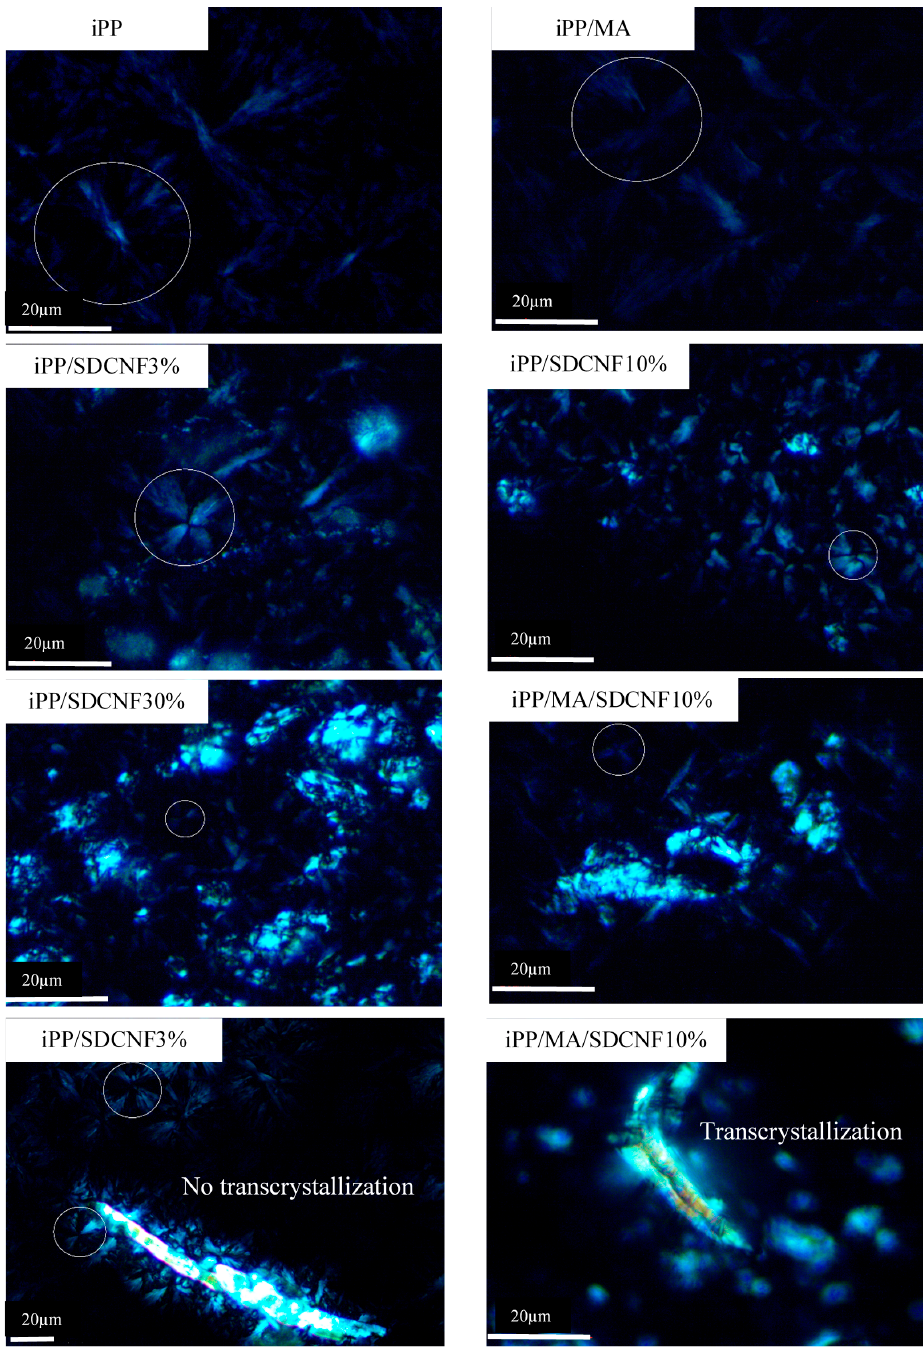
Figure 7. Polarized light micrographs of iPP and iPP/SDCNF composites. Bright and irregular-shape clumps are SDCNF. Inside the circles are the Maltese-cross patterns of iPP spherulites. The last two graphs show the effect of maleic anhydride polypropylene (MAPP) on transcrystallization using different scale bars.